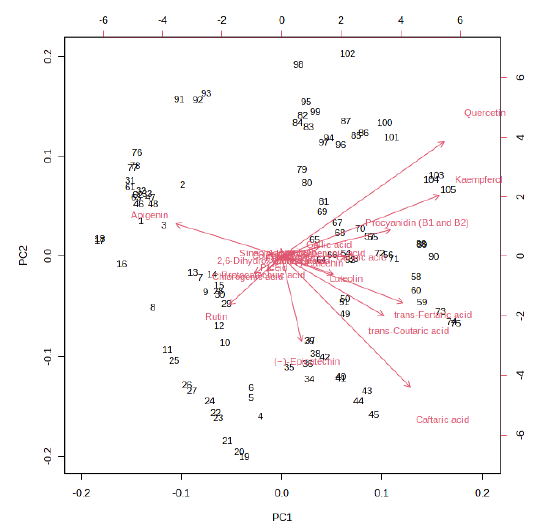
Figure 4. PCA loading plot resulting from the unsupervised k-means clustering of the different (poly)phenols under investigation in the different sub-samples collected during fermentation in IGA and control beers, revealing three major groups according to the log-transformed (poly)phenol concentration.